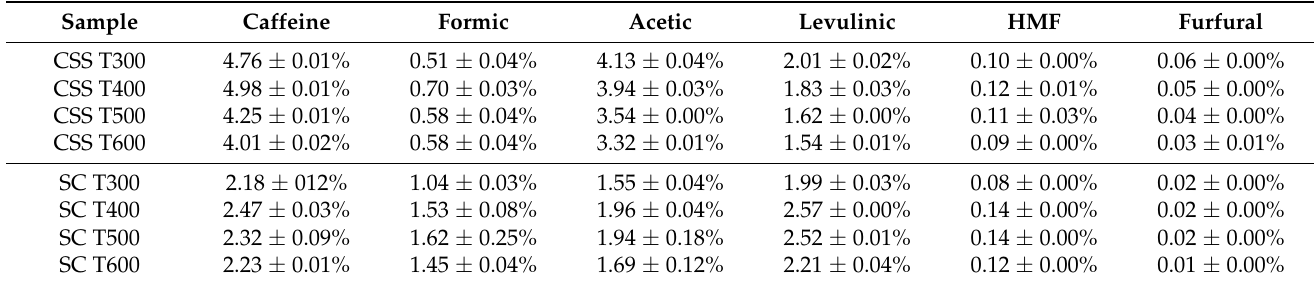
Table 6. HPLC/RID/DAD analyses of the pyrolysis liquids.